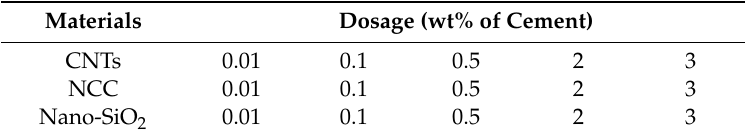
Table 2. The dosage of